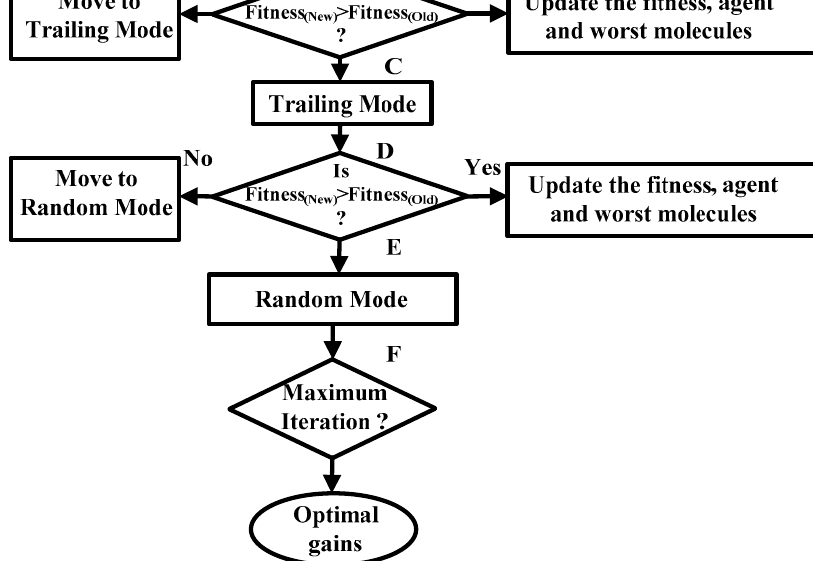
Figure 6. Flowchart of SAO algorithm [28].